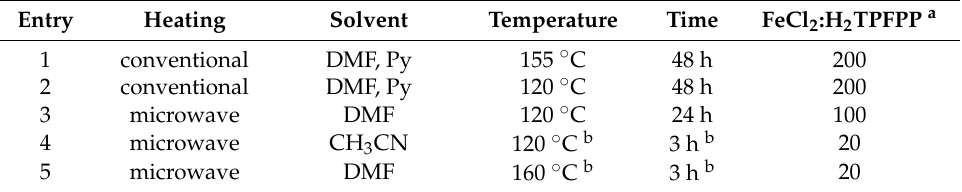
Table 1. Reaction conditions for the metalation reactions using conventional and microwave heating.